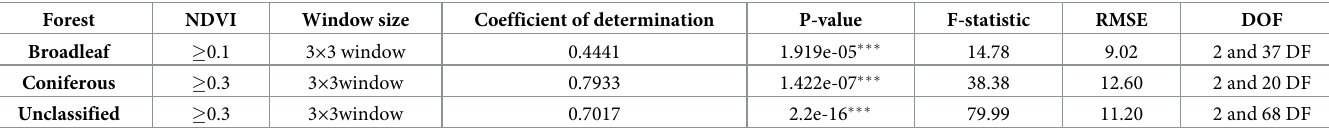
Table 2. Non-linear regression model in different forest types based on NIR band.